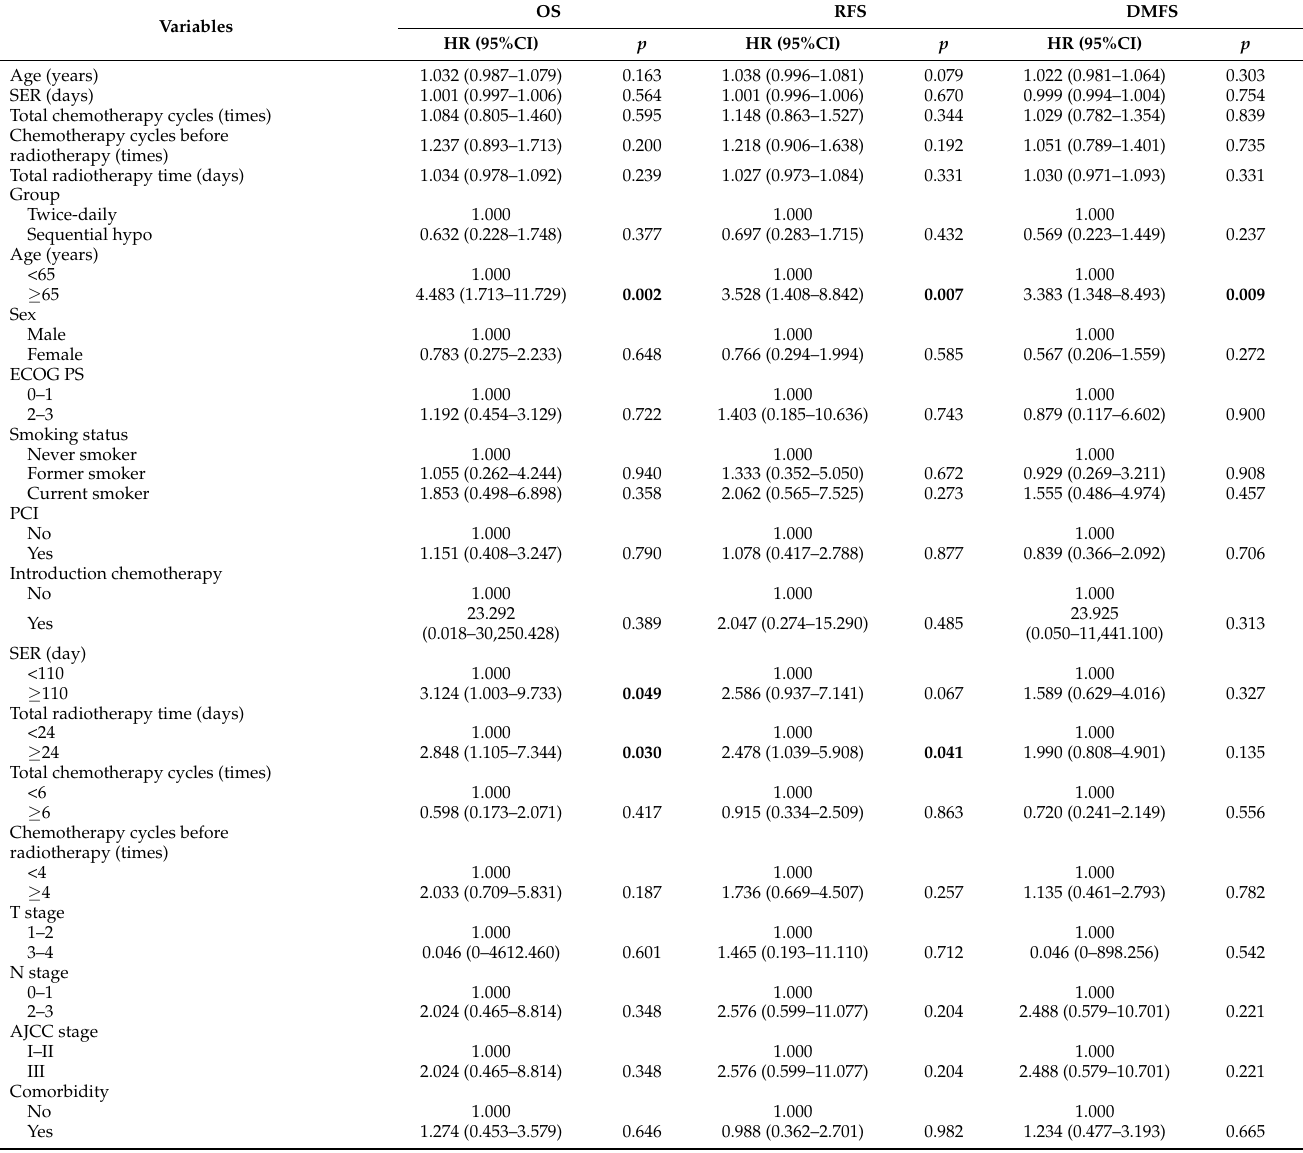
Table 2. Univariable Cox analysis of OS, RFS, and